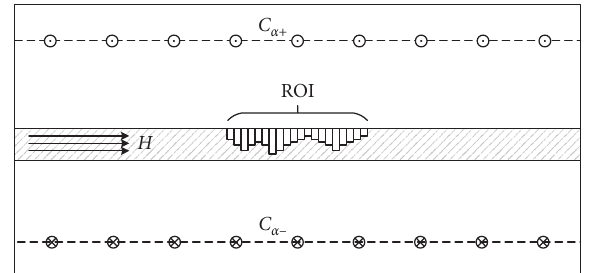
Figure 3: Illustration of simplified FEM model used in this paper with complex depth